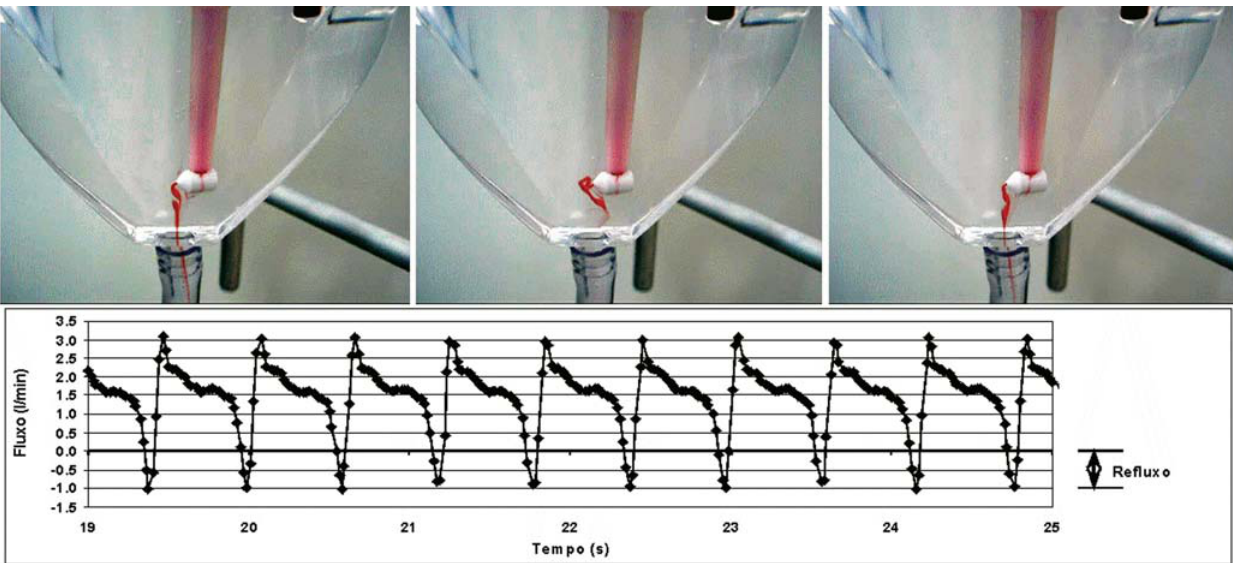
Fig. 5 – Visualização com respectiva medida de refluxo em reservatório de cardiotomia. Fluído análogo ao sangue. Bomba#2. PCDméd =